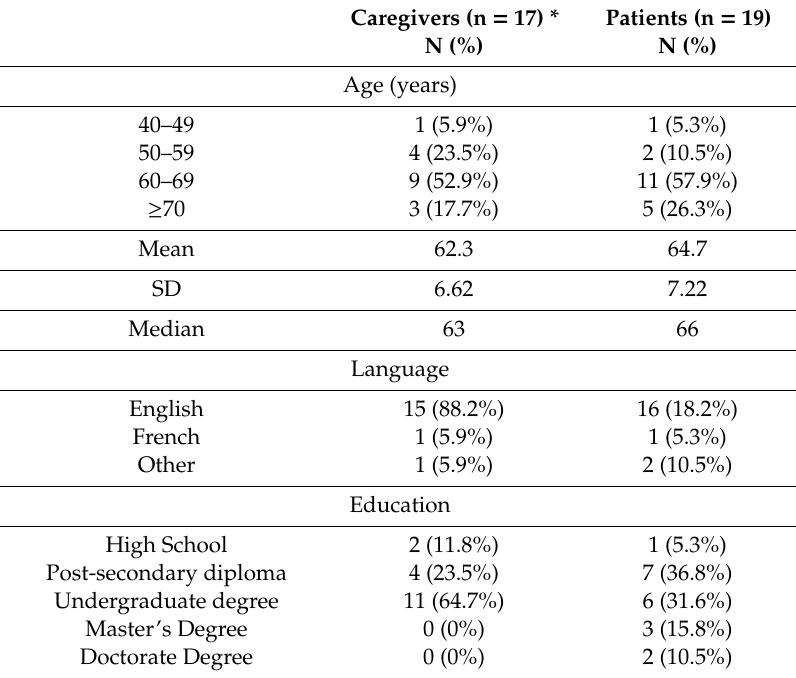
Table 2. Socio-demographic data for participant dyads ( n =